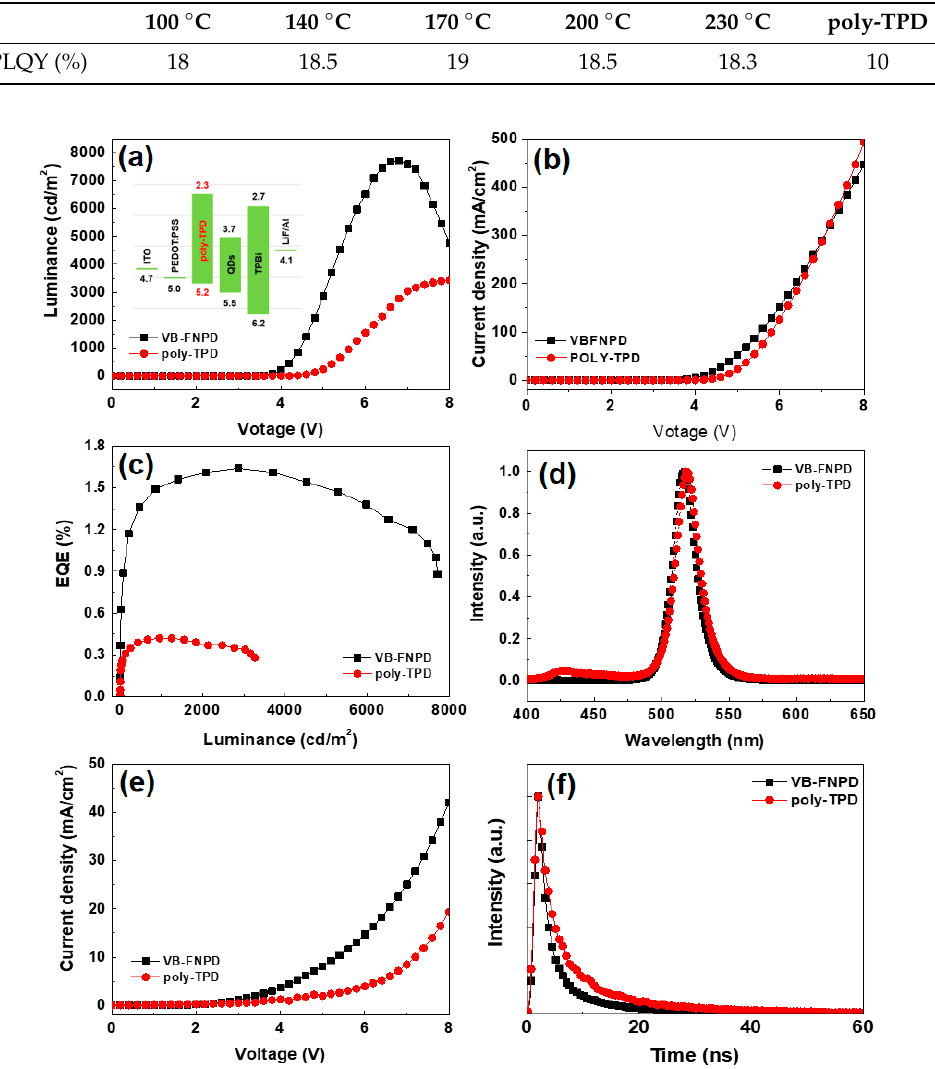
Figure 4. ( a ) L-V, ( b ) J-V, ( c ) EQE, ( d ) EL spectra, and ( e ) electron-only for CsPbBr 3 QD-LED devices Figure 4. ( a ) L ‐ V, ( b ) J ‐ V, ( c ) EQE, ( d ) EL spectra, and ( e ) electron ‐ only for CsPbBr 3 QD ‐ LED devices with VB-FNPD and poly-TPD HTLs. ( f ) TRPL decay profiles of perovskite CsPbBr 3 QD layers spun on with VB ‐ FNPD and poly ‐ TPD HTLs. ( f ) TRPL decay profiles of perovskite CsPbBr 3 QD layers spun VB-FNPD and poly-TPD films. on VB ‐ FNPD and poly ‐ TPD films.